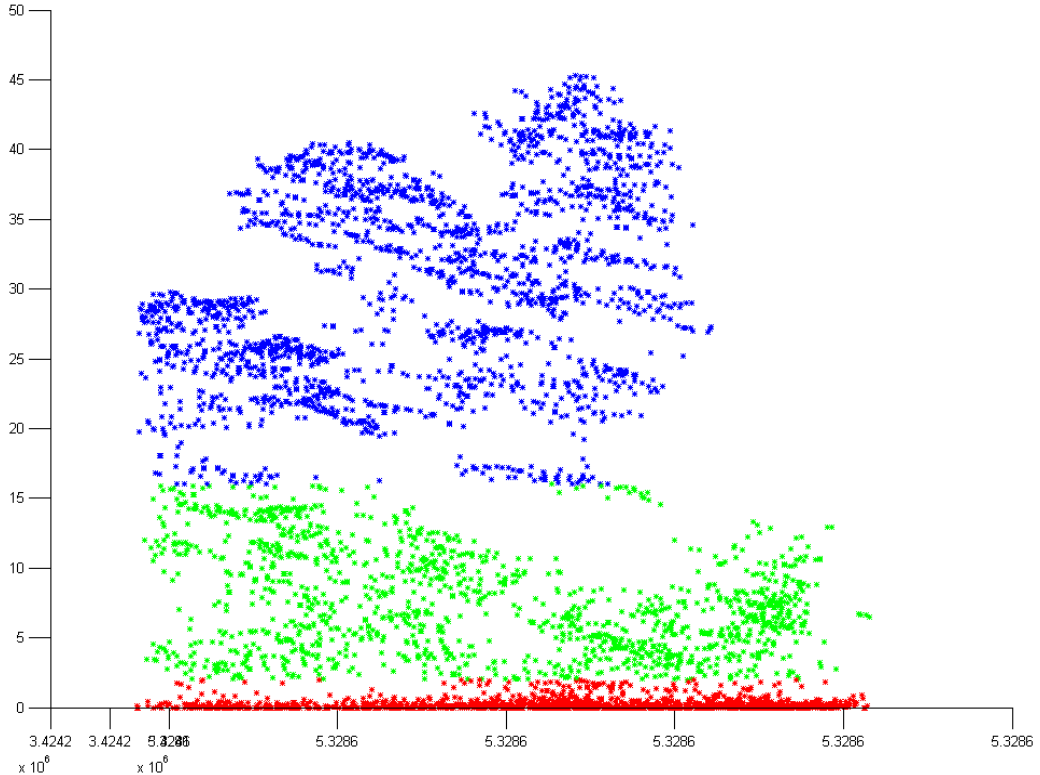
Figure 7. Cell 6 - distribution of normalized 3-D LIDAR points, projected into a freely chosen vertical plane, at 3 different height levels (0–2 m, 2–16 m, and above 16 m) shown in 3 different colors (red, green and blue, respectively). The x and y coordinate values (in meters) are displayed horizontally and the z value (in meters) is displayed